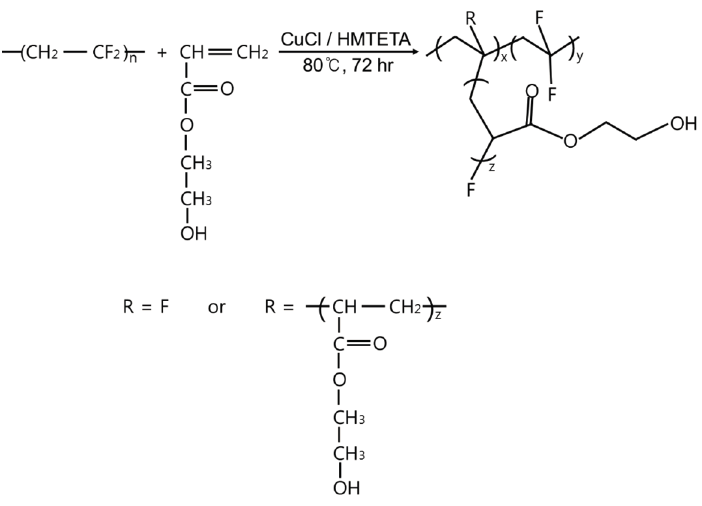
Figure 1. Polymerization process of